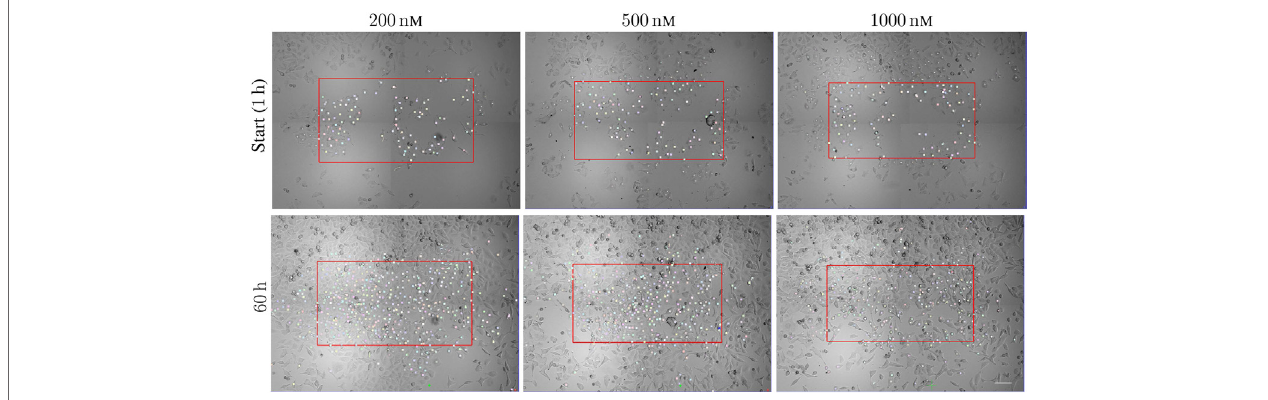
FigUre 1 | Sample images from time-lapse recording for single-cell tracking. The red frame is large enough to cover initially 100 cells with descendants inside the imaged area during the following time of recording. The frames are of size 888 × 484 μ m 2 , 858 × 452 μ m 2 , and 840 × 434 μ m 2 (respectively from left to right). The cells are exposed to 200, 500, and 1,000 nM. The lower row shows the cell population at 60 h from the start of exposure. Note the increase of the cell populations from the start to 60 h (largest increase for cells exposed to 200 nM). Many cells move out of the initial red frame during the actual period. Scale bar: 100